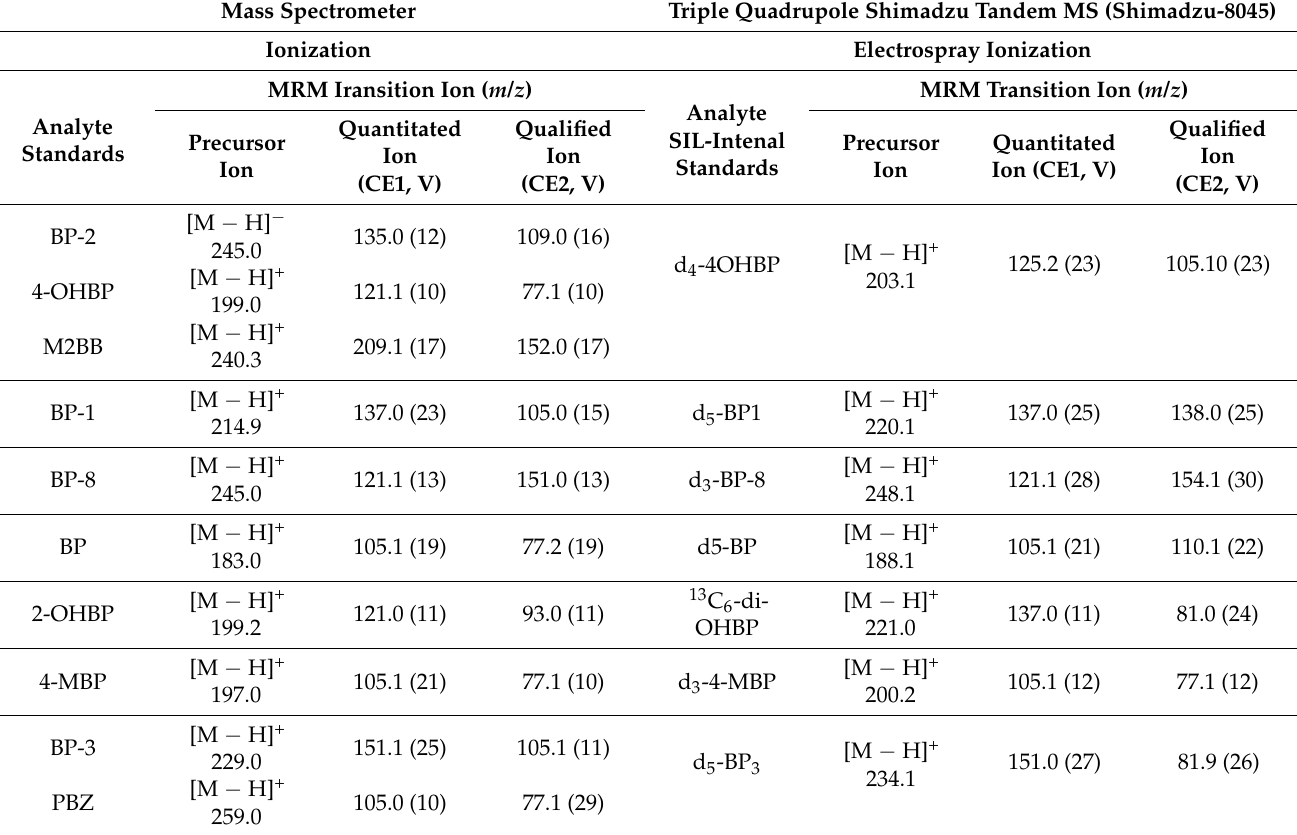
Table 1. Tandem mass spectrometry parameters for BP and BP analogs and corresponding stable isotope labeling